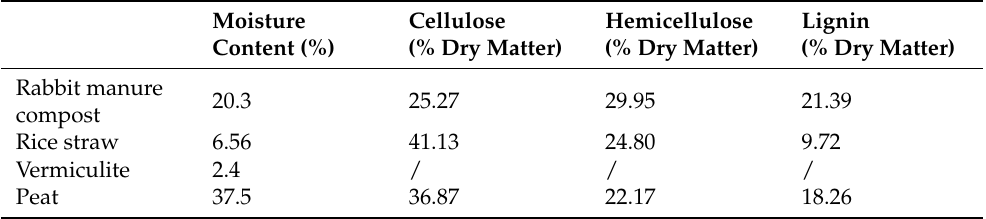
Table 1. Moisture and lignocellulose contents of main growing media materials.